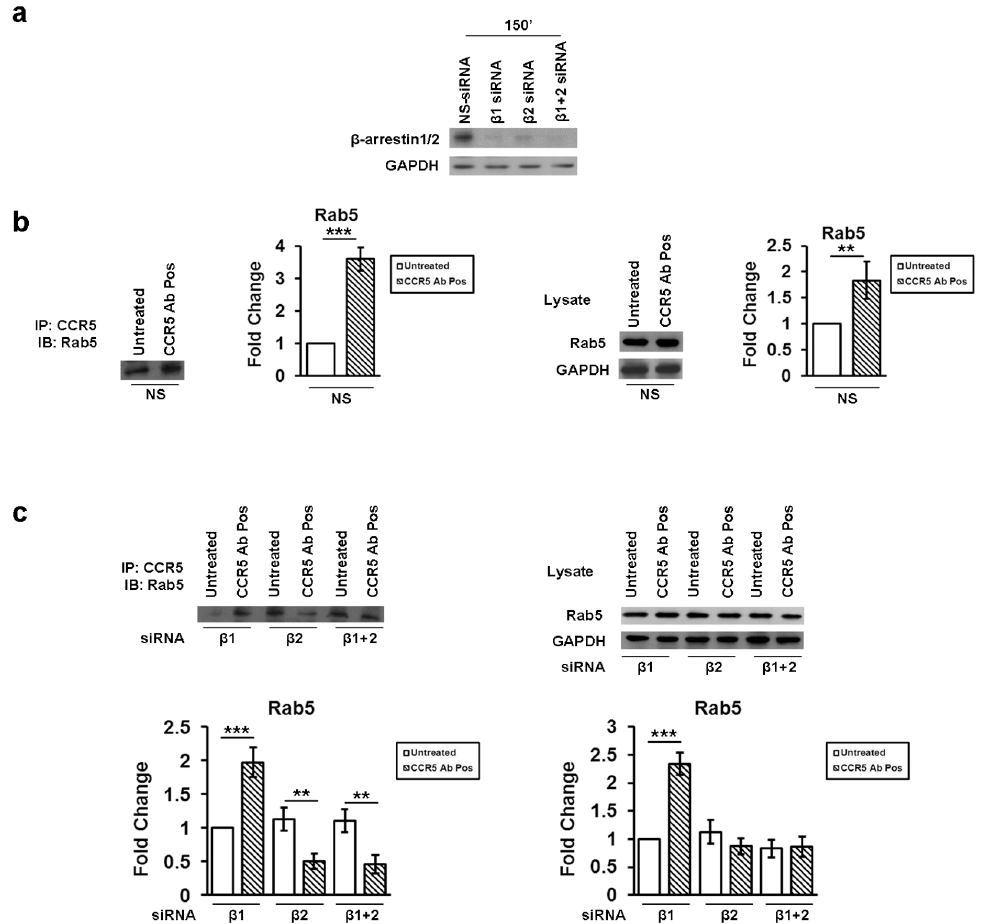
Figure 4. Role of siRNAs specific for β -arrestin1/2 in the interaction between CCR5 and Rab5. ( a ) Immunoblot analysis for β -arrestin1/2 and GAPDH in whole lysate from R5-SupT1-M10 cells nucleofected with siRNAs specific for β -arrestins: -1 ( β 1), -2 ( β 2) or both ( β 1+2) and with NS-siRNA (negative control); ( b , c ) after 5 h of nucleofection, the cells were collected at 150 min: 30 min incubation with CCR5 Ab Pos or not, wash, additional 120 min incubation in medium without stimuli. The immunoprecipitation of CCR5 with Rab5 was assessed by immunoblot. Total protein extracts were tested by Western blot as an experimental control. Band density was determined with the TINA software (version 2.10, Raytest, Straubenhardt, Germany) and it is shown as fold change over a housekeeping gene. Bar graphs represented mean ± SD of three independent experiments. Student’s t -test was performed and p -values are shown. * p ≤ 0.05, ** p ≤ 0.01, *** p ≤ 0.001, **** p ≤ 0.0001. Data are representative of three independent experiments.